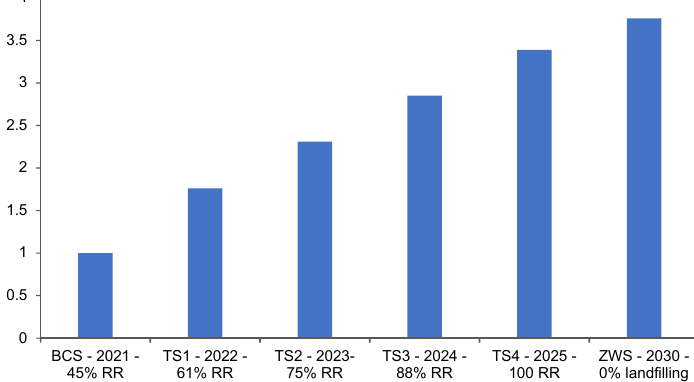
Figure 6. Variation factor for all scenarios with respect to the BCS with variation factor equal to 1. The terms BCS, TS, and RR represent BCS, treatment scenario, and recycling rate, respectively.